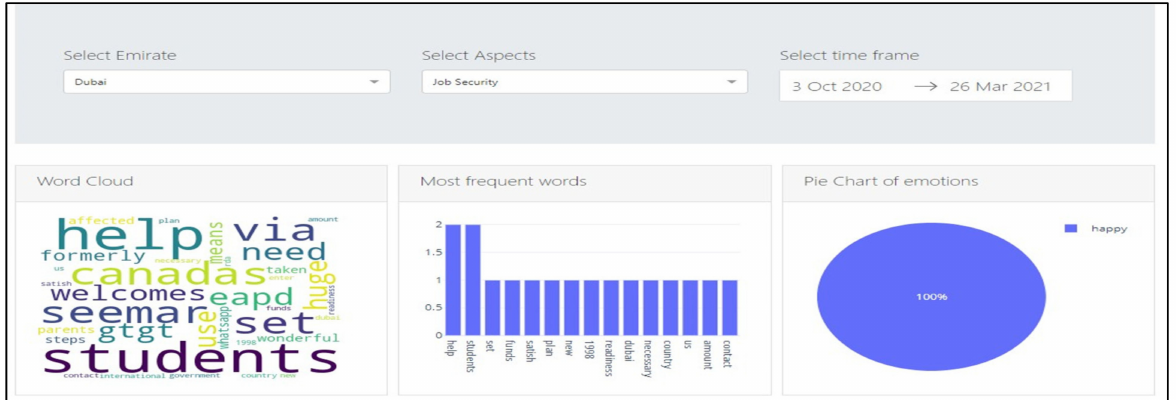
Figure 13. Testing